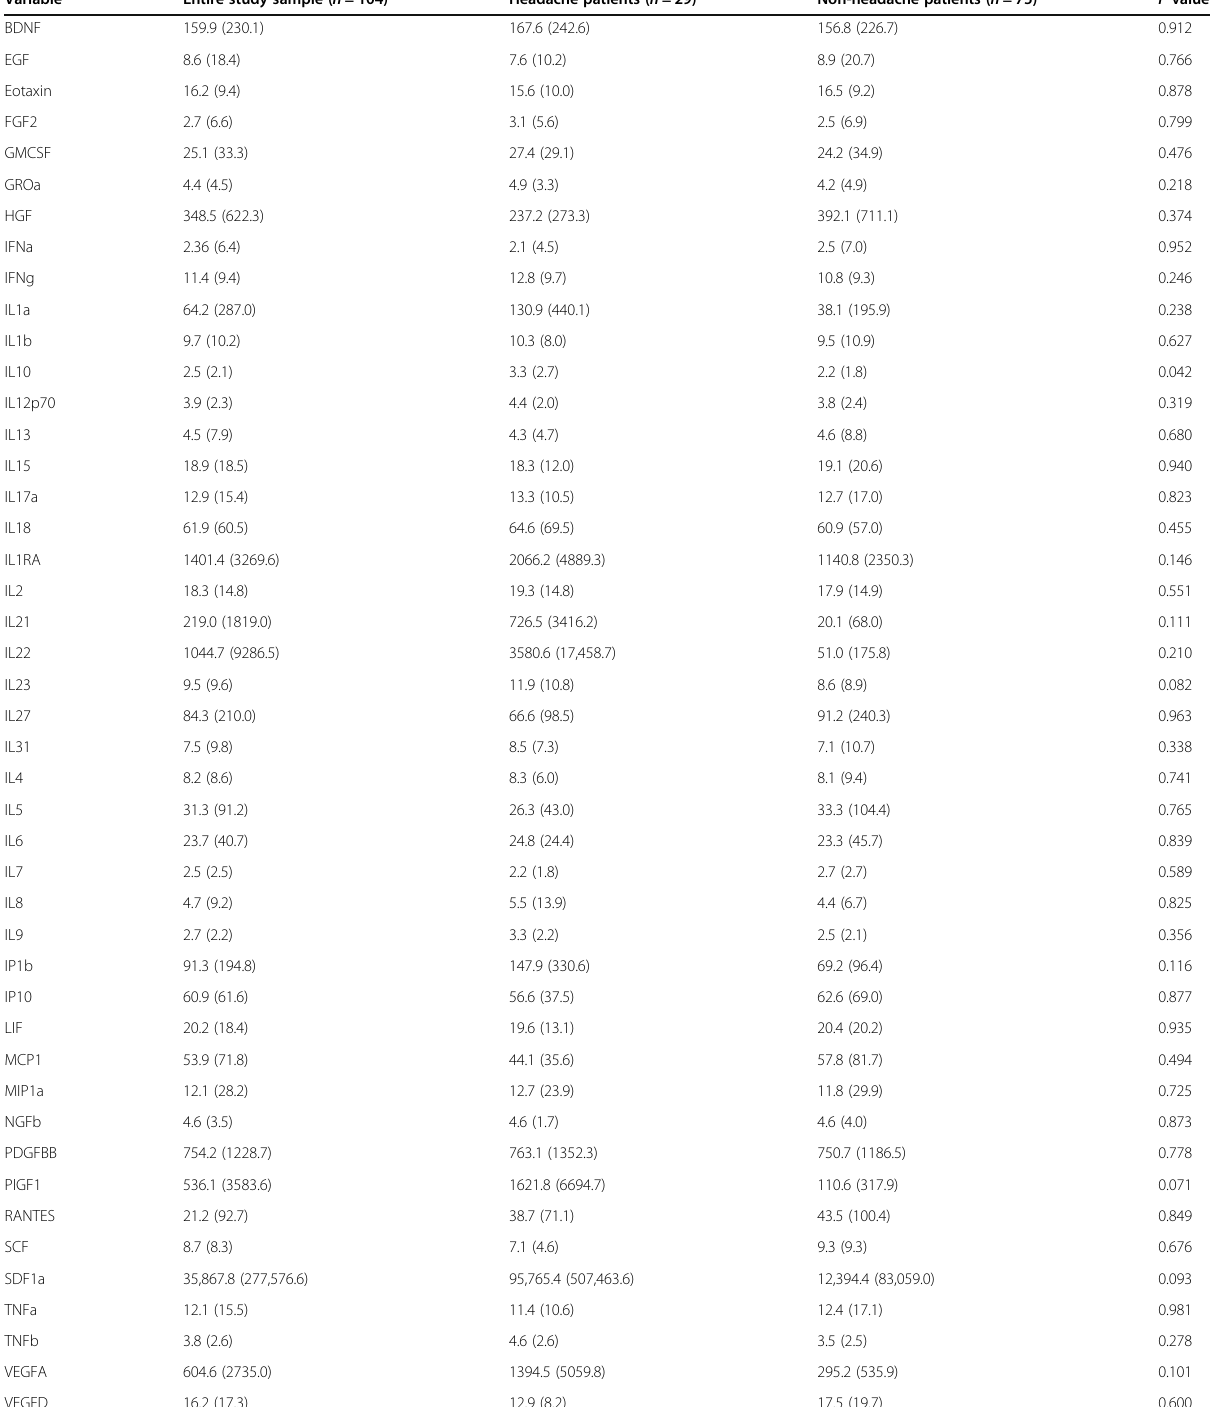
Table 4 Comparison of cytokines and interleukins by ANCOVA test, adjusting for age sex, baseline disability and COVID-19 severity Variable Entire study sample ( n =104) Headache patients ( n